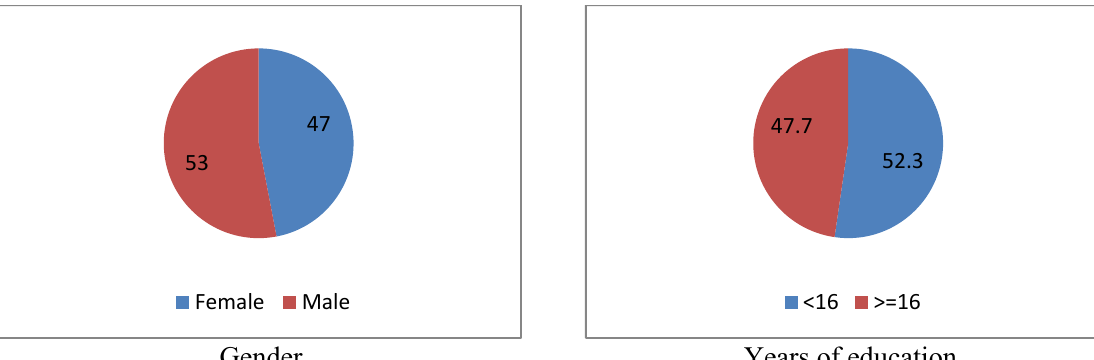
Fig. 2. Personal characteristics of the